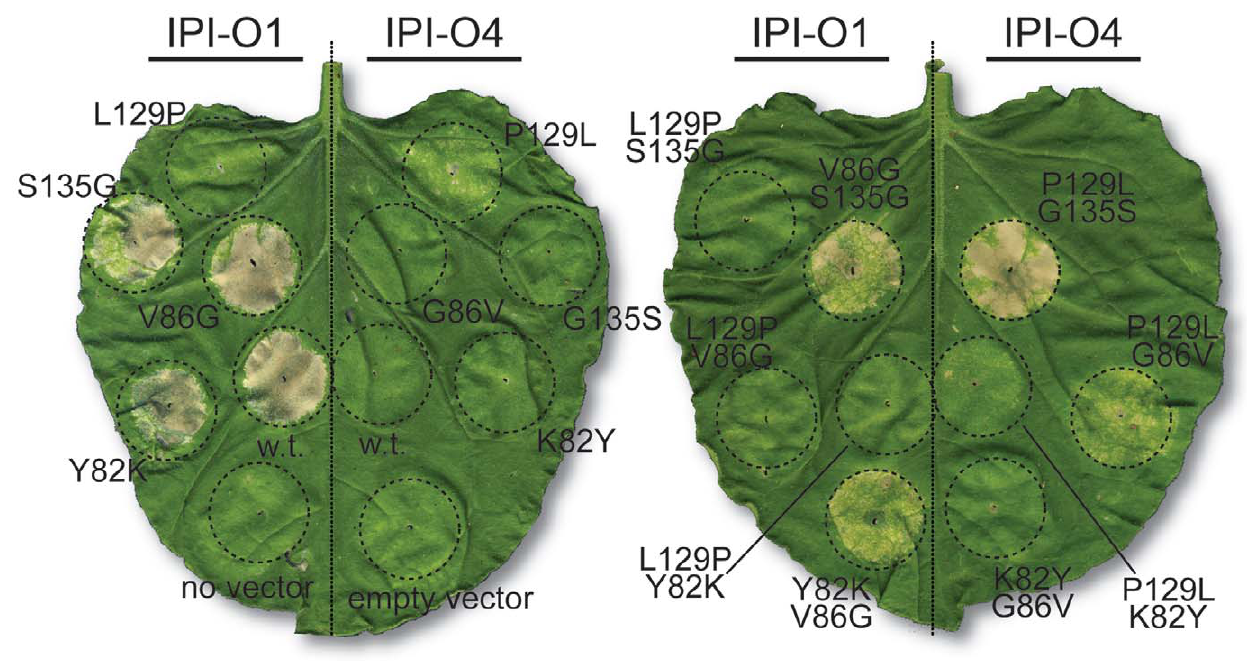
Figure 4. Induction of hypersensitive cell death by IPI-O1 and IPI-O4 mutants inplanta . A. tumefaciens strains expressing IPI-O, IPI-O mutants, or the indicated controls were infiltrated into leaves of RB transgenic N. benthamiana plants. Leaves were photographed at 6 days after infiltration.